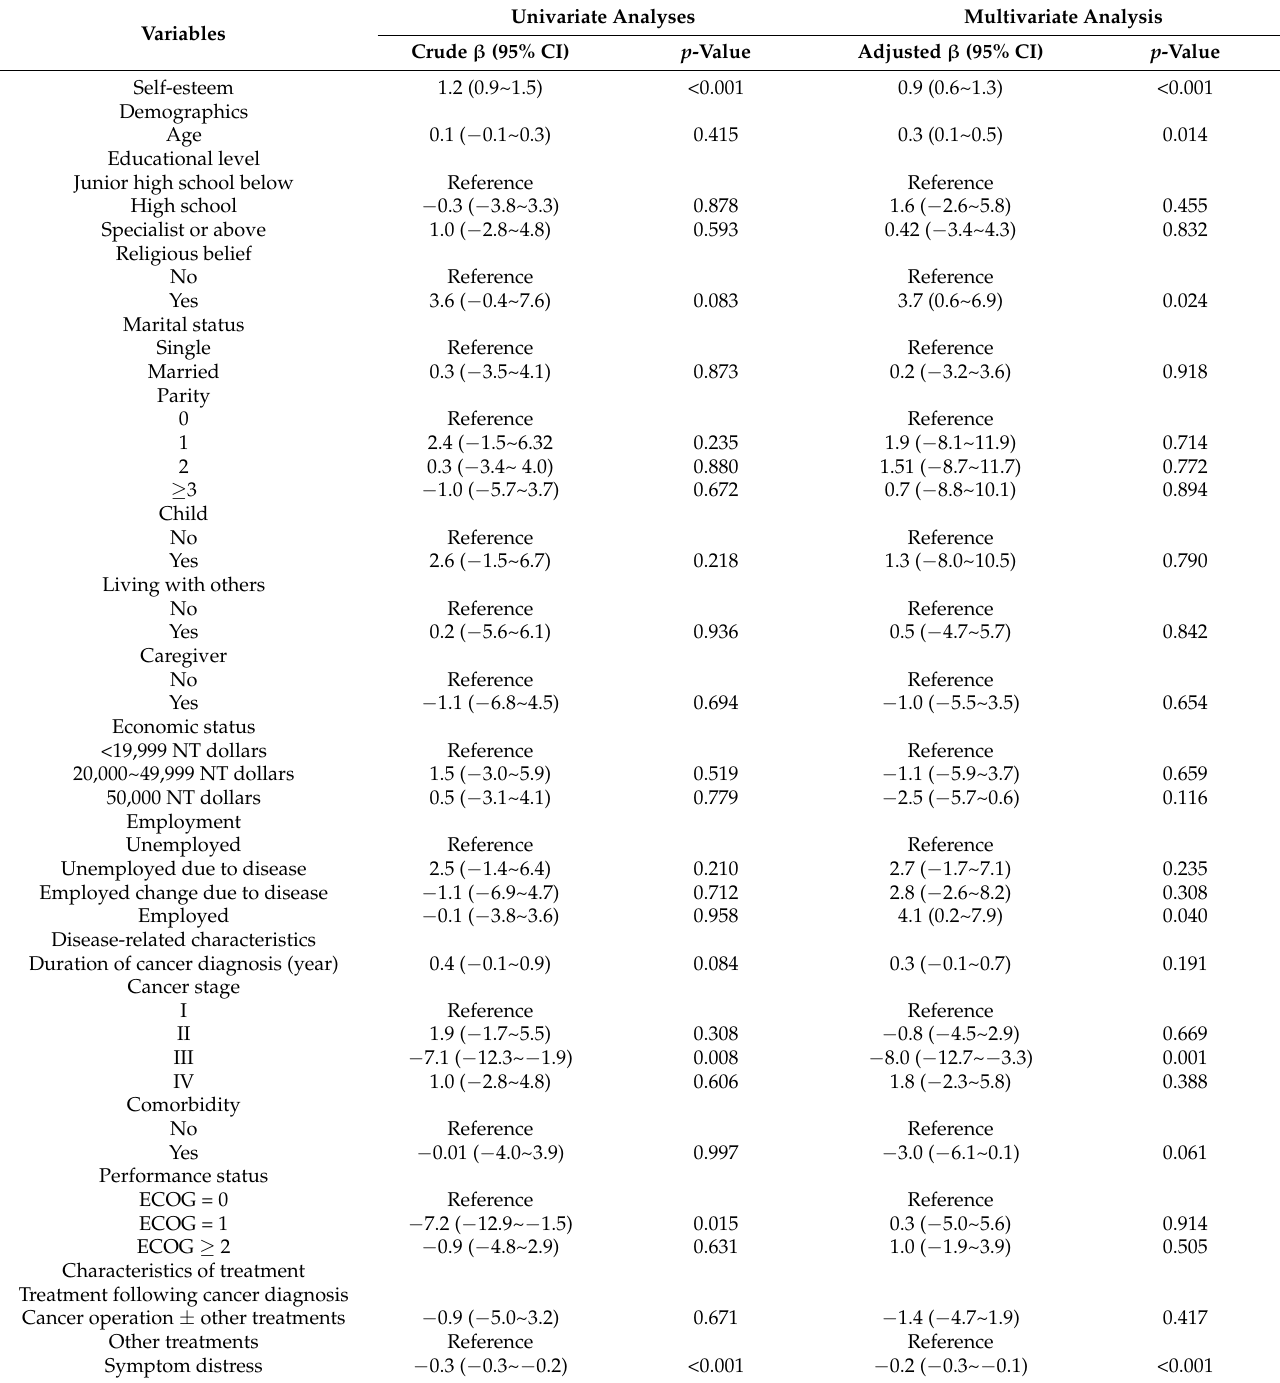
Table 3. Predictors of mental adjustment among patients with breast cancer ( n =